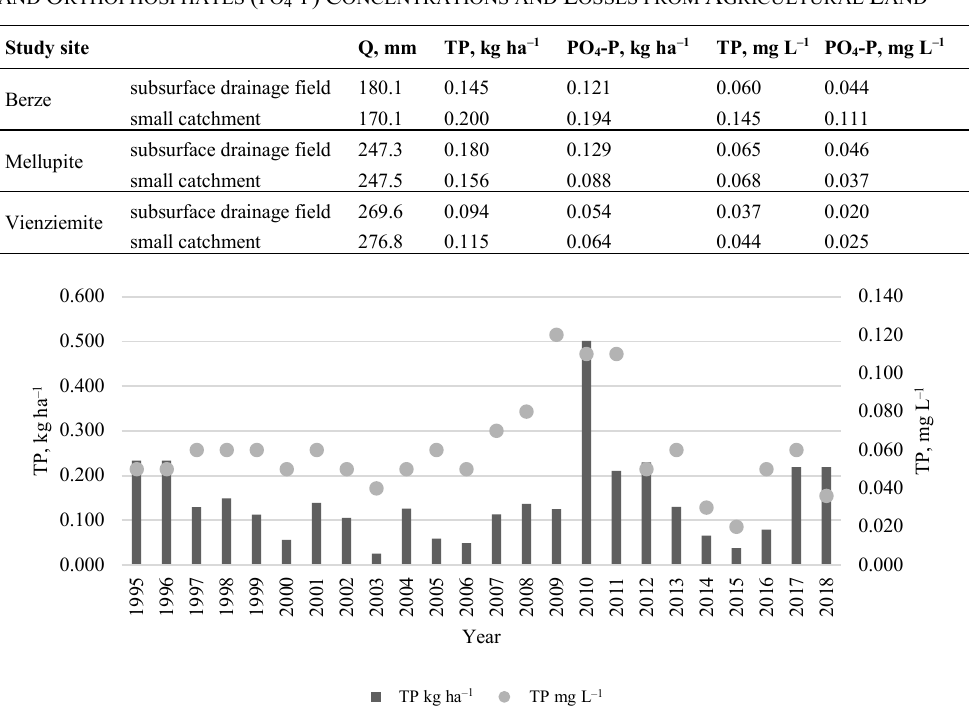
Fig. 2. Annual losses (kg ha − 1 ) and concentrations (mg L − 1 ) of total phosphorus (TP) in the Berze subsurface drainage field.